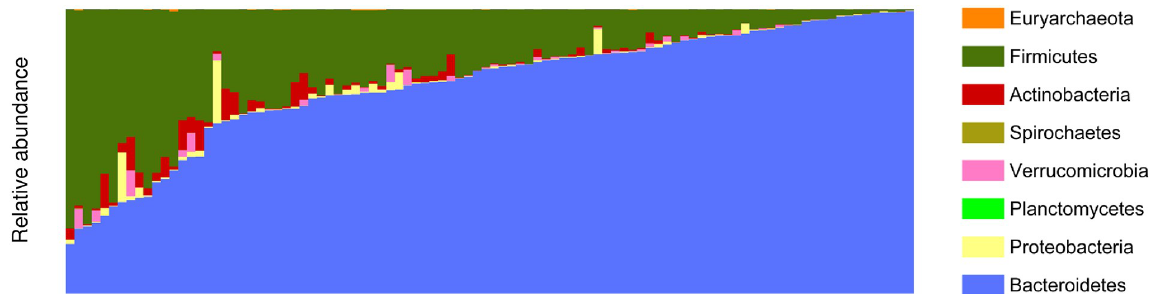
Fig 2. Stacked bar plot of phylogenetic composition of all microbiome taxa in this study collapsed at the phyla level in fecal samples. Green bars represent Firmicutes and the blue represent Bacteroidetes , the two most abundant bacterial families. For aesthetic purposes the samples (n = 98, bottom) were sorted according to their composition of Bacteroidetes and Firmicutes to demonstrate how the baseline gut microbiome results from this study could be used in conjunction with results from past